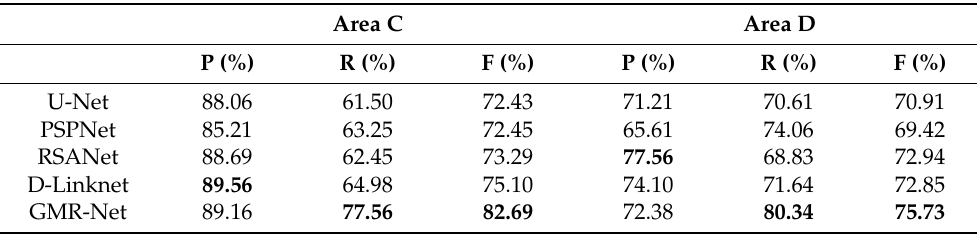
Table 6. A results comparison between the GMR-Net method and other methods in research areas C and D, where the values shown in bold are the best.